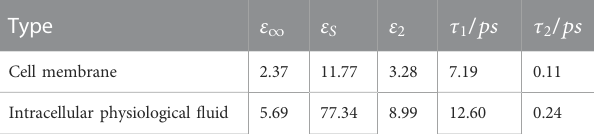
TABLE 2Resultsof fi tting the parametersofthe second-order Debye modelfor cell membrane and intracellular physiological fl uid.